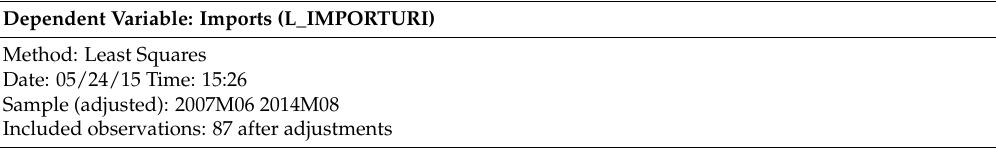
Table 3. Regression model—Imports as dependent